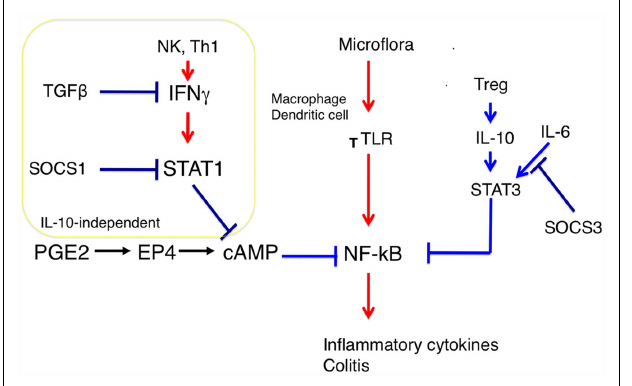
FIGURE 2 | Role of SOCS1 and PGE2 in macrophage/dendritic cell activation. T reg /IL-10/STAT3 and PGE2/cAMP are two independent anti-inflammatory mechanisms, although precise molecular mechanisms have not been clarified yet. SOCS1 is involved in the cAMP suppression system but not in the IL-10 system. SOCS1 prevents the breakdown of cAMP-mediatedTLR signaling by suppressing STAT1. On the other hand, SOCS3 may keep properTLR signaling by inhibiting IL-6-mediated STAT3 activation. SOCS3 has no effect on IL-10 mediated anti-inflammatory